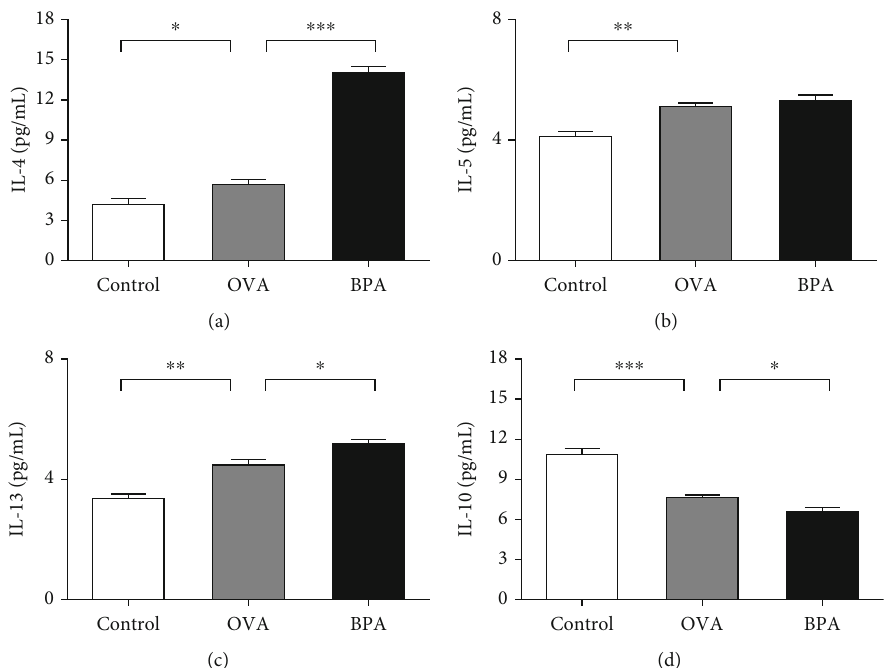
Figure 4: BPA increased the levels of Th2 cell e ff ector cytokines and repressed cytokine expression by Tregs in the nasal mucosa. The protein expression levels of (a) IL-4, (b) IL-5, (c) IL-13, and (d) IL-10 were measured using the CBA Flex Set (BD Biosciences). Data are expressed as means ± SEM ; n = 5 in each group. ∗ P < 0 : 05 ; ∗∗ P < 0 : 01 ; ∗∗∗ P < 0 : 001 .